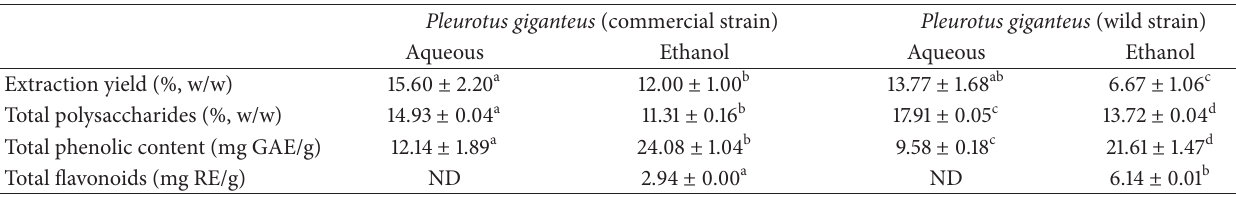
Table 4: Total polysaccharides, phenolics, and flavonoids present in the crude aqueous and ethanol extracts of basidiocarps of Pleurotus giganteus .